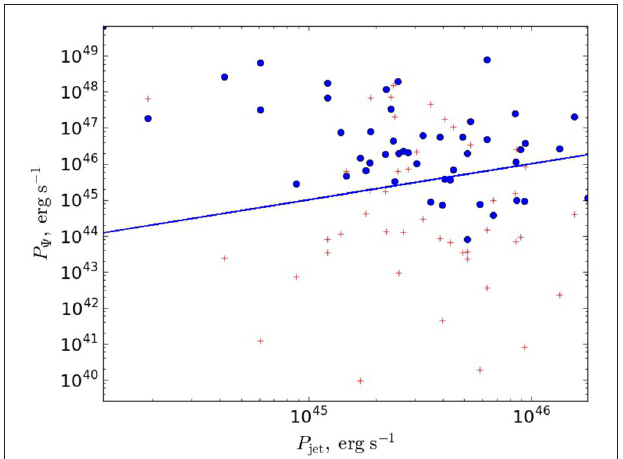
FIGURE 2 | The histogram showing the number of sources with the ration of calculated power P 9 to the total jet power P jet , the ratio is in the log-scale. We see the systematic excess of power estimated through the flux against the jet power by a factor of